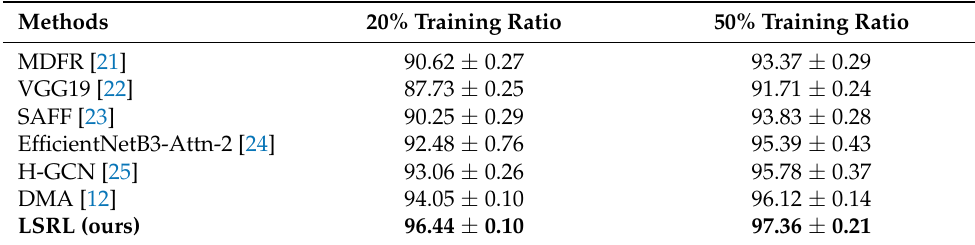
Table 1. The OA(%) of different methods on AID dataset.